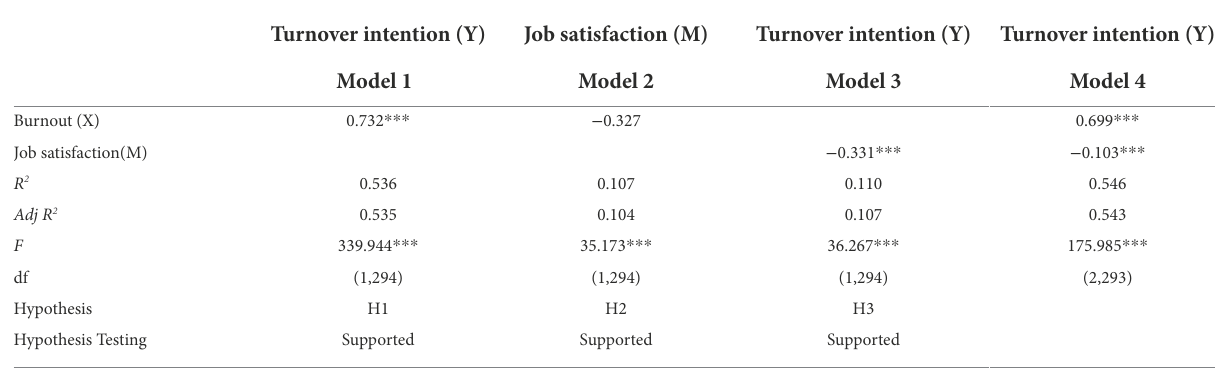
TABLE 5 Tests for the mediating effect of Job Satisfaction.